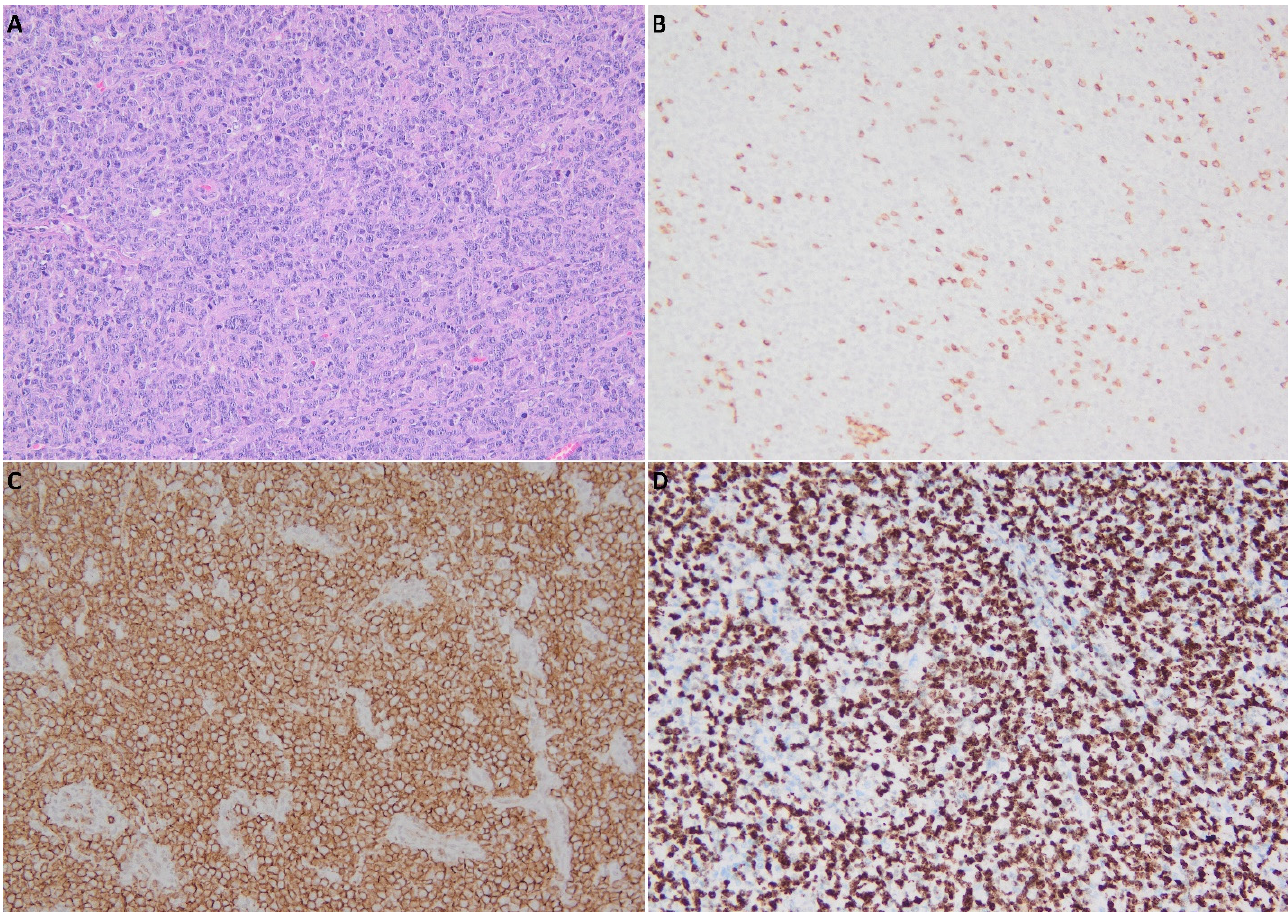
Figure 2. Histopathology and immunohistochemistry assessments: ( A ) Large size, lymphoid-type cells with increased rates of mitotic activity, HE, original magnification ×20; ( B ) positive staining for CD3 in reactive T cells, original magnification ×20; ( C ) intense and diffuse positive CD20 staining in tumor cells, original magnification ×20; ( D ) cellular proliferation index ki67, original magnification ×20.